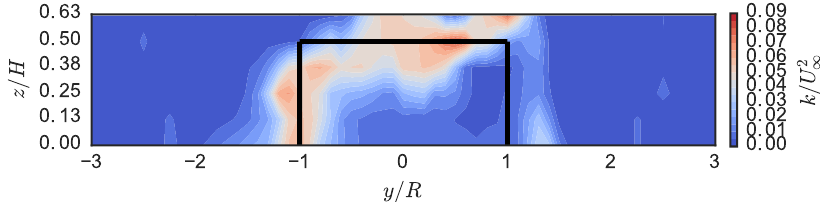
Figure 11. Turbulence kinetic energy at x / D = 1, λ = 1.9, and Re D = 1.0 × 10 6 .